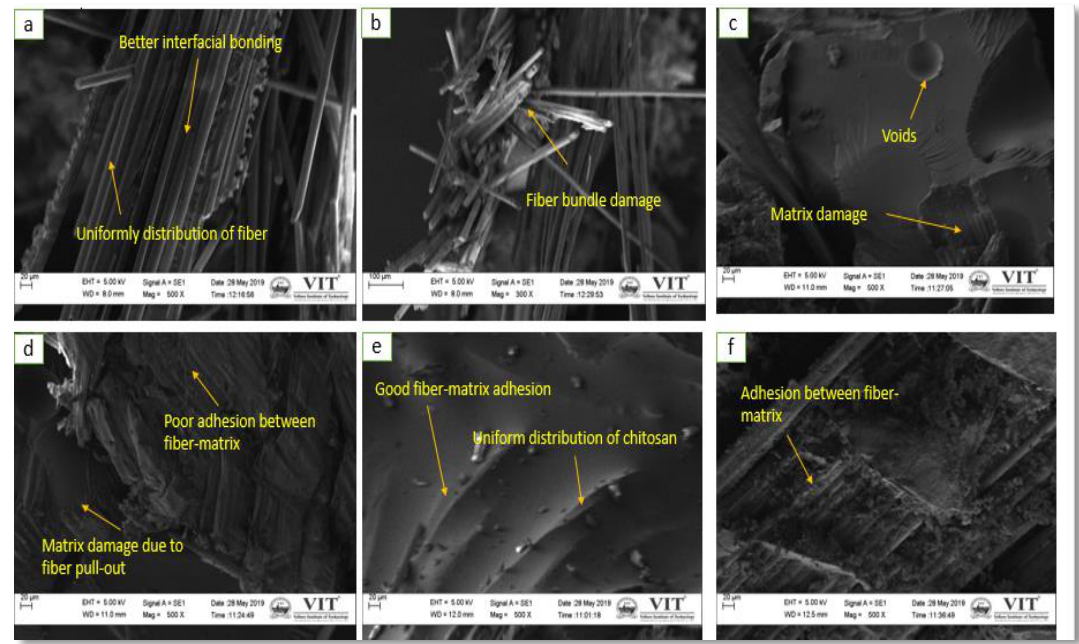
Figure 11. Flexural fractured surface of di ff erent composite: ( a ) A1, ( b ) A2, ( c ) A3, ( d ) A4, ( e ) A5, and ( f ) A6 composites.